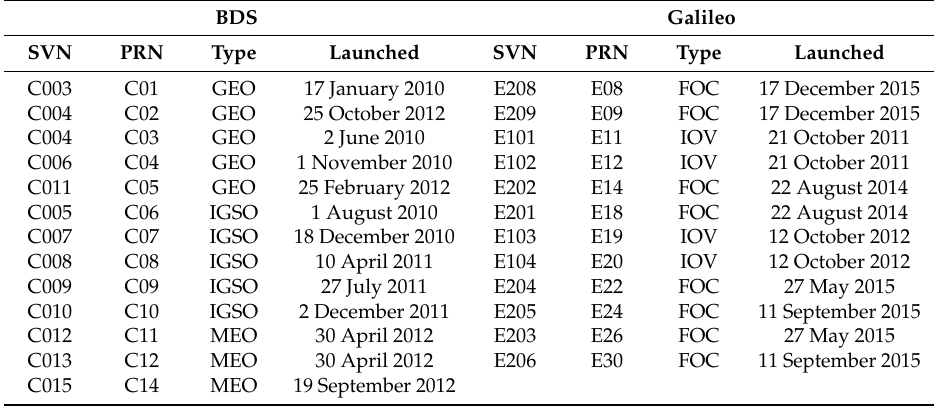
Table 1. BeiDou and Galileo satellites’ on-orbit services (December 2015; GEO: geostationary earth orbit, IGSO: inclined geo-synchronous orbit; MEO: medium earth orbit; FOC: full operational capability; IOV: in-orbit validation).